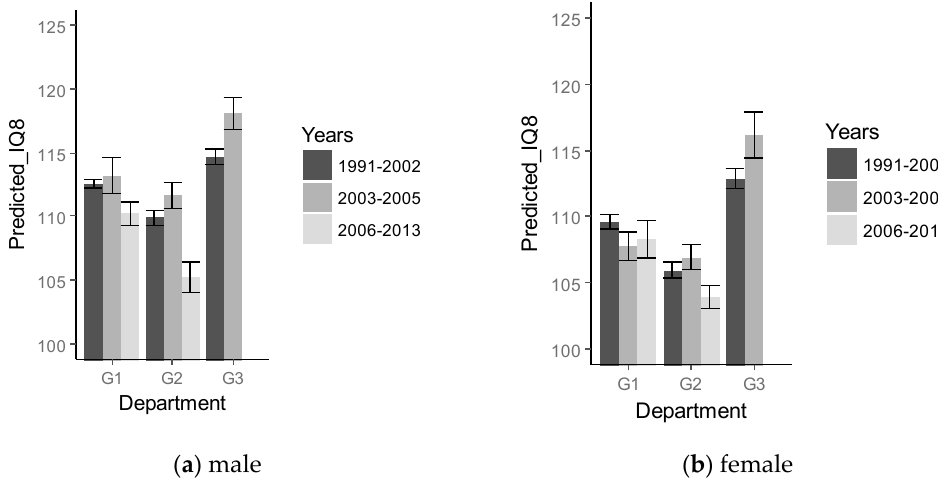
among women and men than in other groups. Figure 6. Dynamics of spatial generalization (subtest IQ8) among male ( a ) and female ( b ).